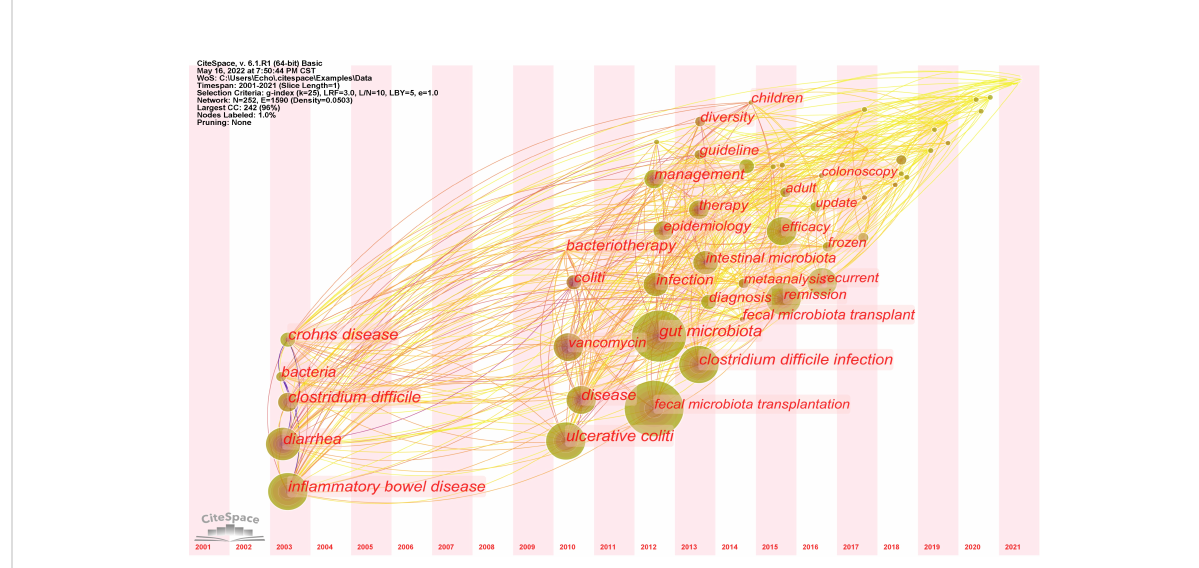
FIGURE 4 Chronological variation of the keywords related to FMT from 2001 to 2021. The size of each dot represented the frequency of keywords occurrence, while the links indicated the co-occurrence of